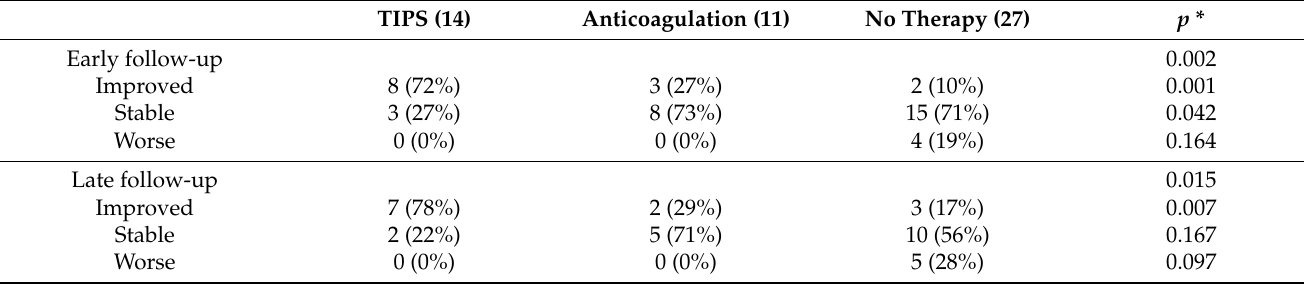
Table 2. Overall change in portomesenteric venous system patency on follow-up cross-sectional imaging from baseline using Yerdel grades.